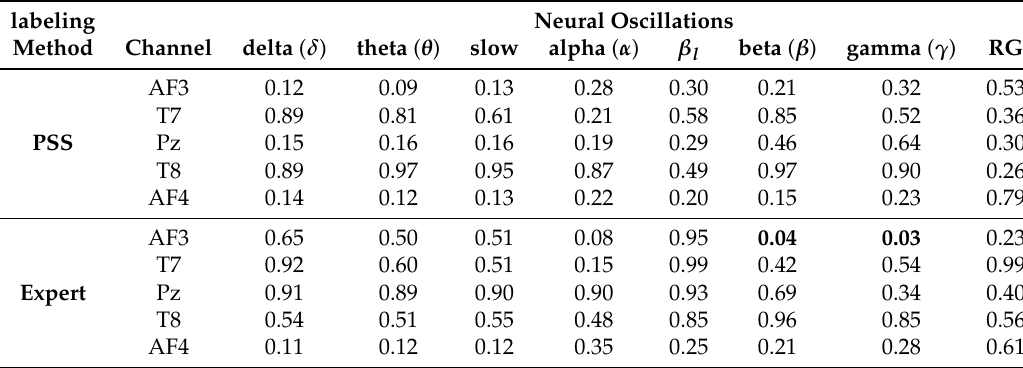
Table 3. Results for the t -test on various neural oscillations including PSS and expert-based labeling methods.